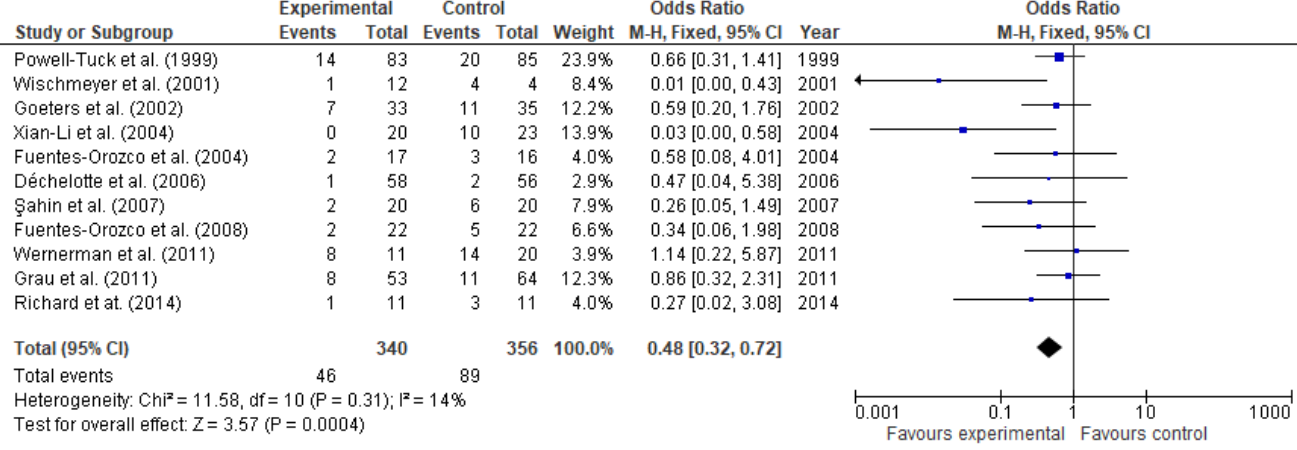
Figure 11. Patient mortality: fixed-effects meta-analysis and forest plot from studies providing supplementation of glutamine.